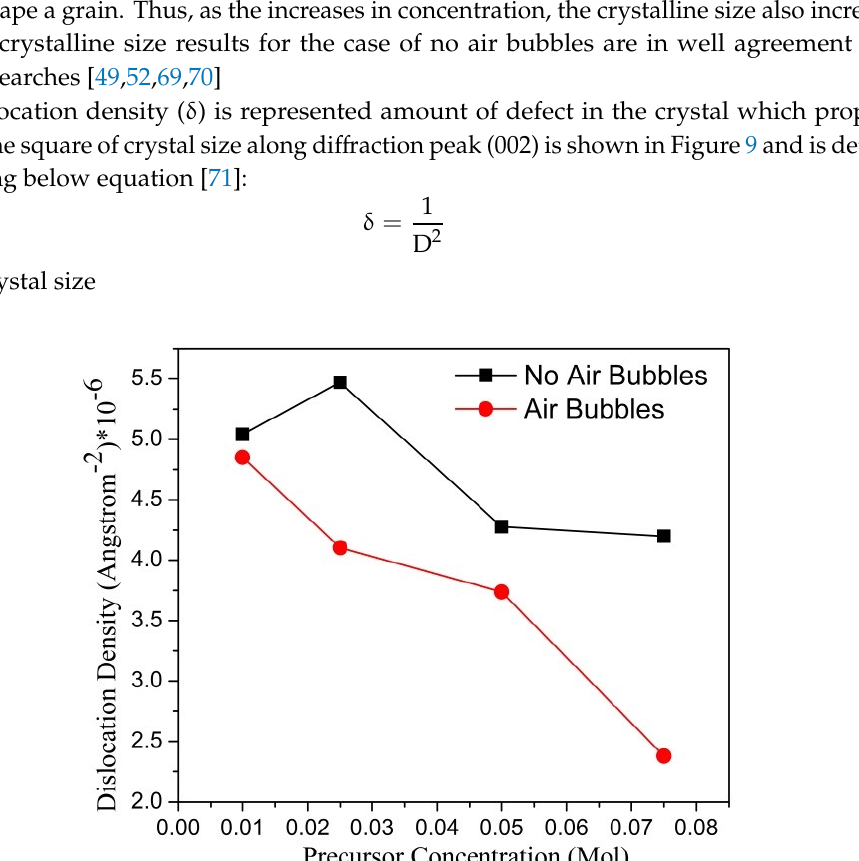
Figure 8 a. Variation of crystalline size and ( b ) full-width at half-maximum FWHM along diffraction peak (002) at precursor concentrations of ZnO nanorods grown in in the presence and absence of air bubbles.